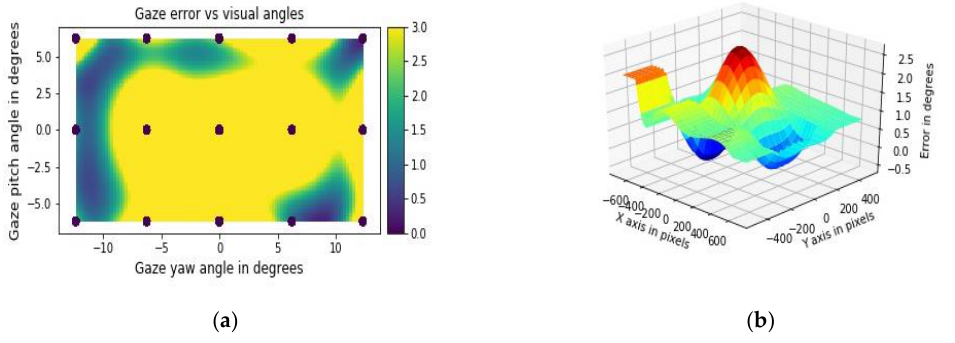
Figure 4. Outputs from using GazeVisual-Lib codes: ( a ) 2D surface distribution of gaze errors as a function of visual angles; ( b ) 3D plot of gaze errors as a function of display dimensions in pixels.